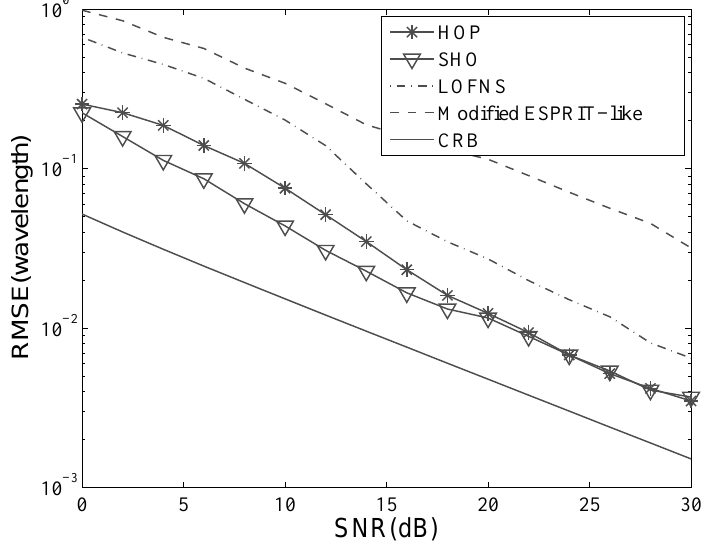
Figure 6. RMSE versus SNR: range of the first source.